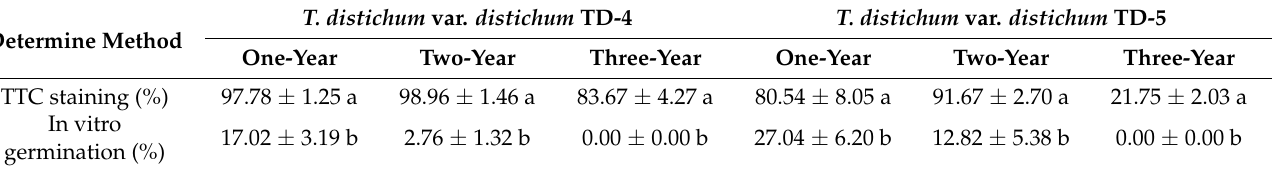
Table 6. Comparison of viability of pollen after storage at − 20 ◦ C of T. distichum var. distichum measured by TTC staining and in vitro